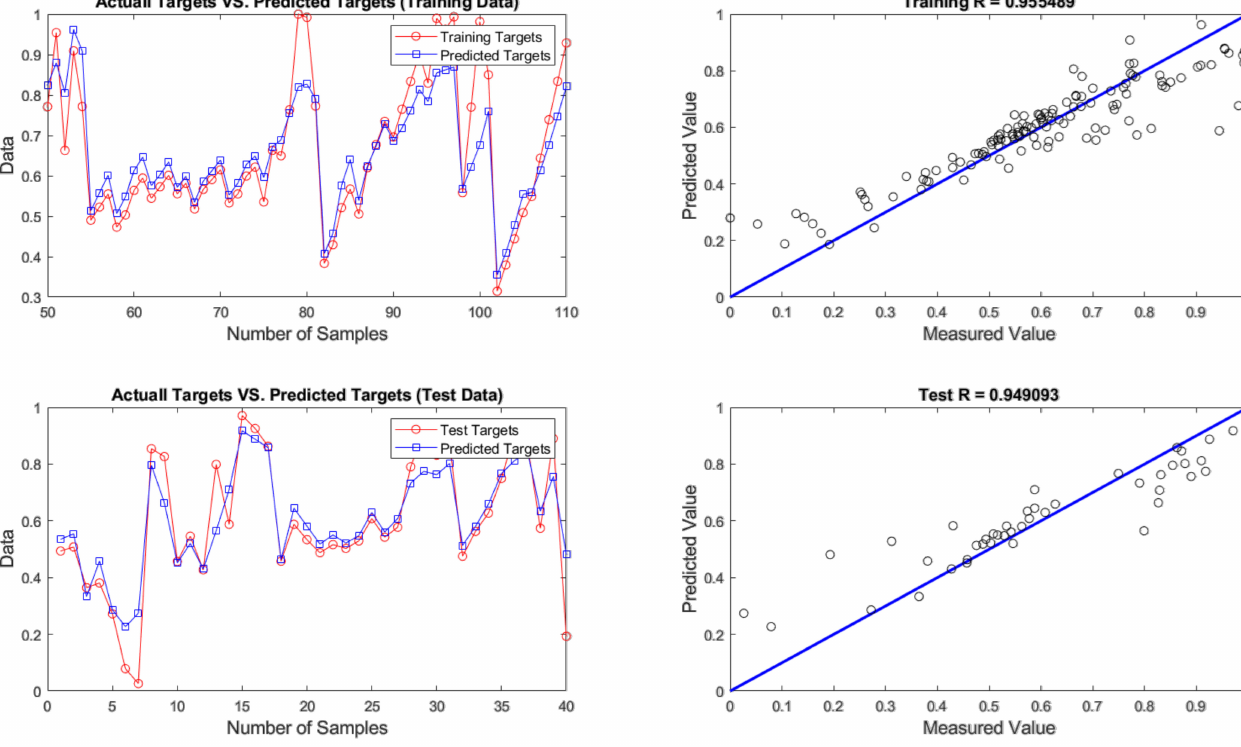
Figure 17. Results of training and testing data for predicting chromium removal using genetic